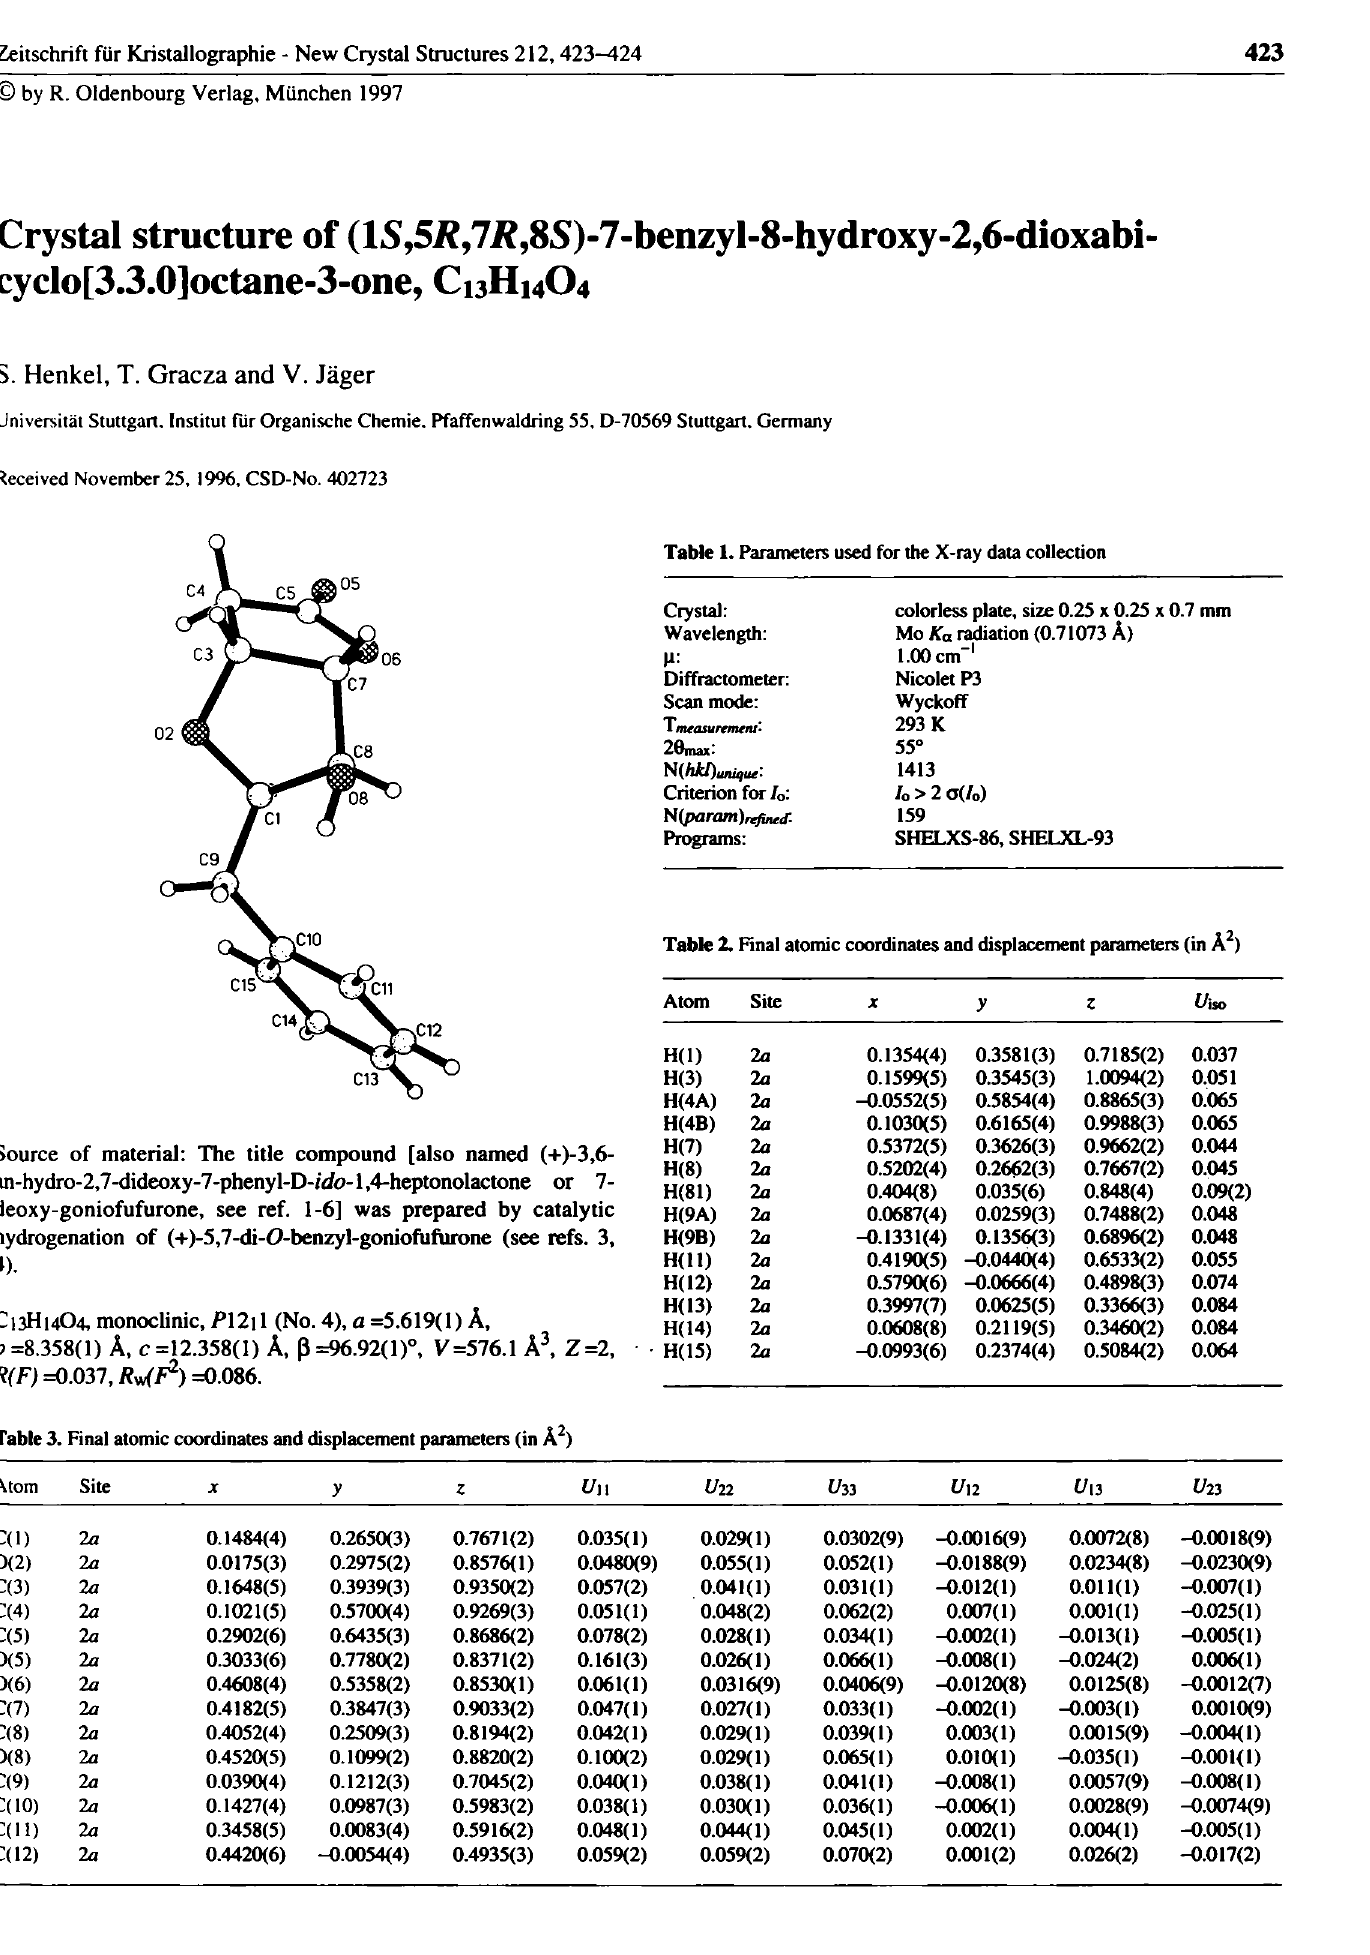
Table 3. Final atomic coordinates and displacement parameters (in Â 2